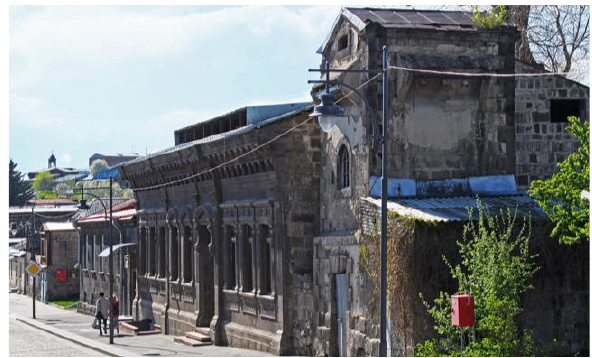
Figure 14. “House with two cornices” and electrical substation turret on Rustaveli Street. Photo by the author, 2019.